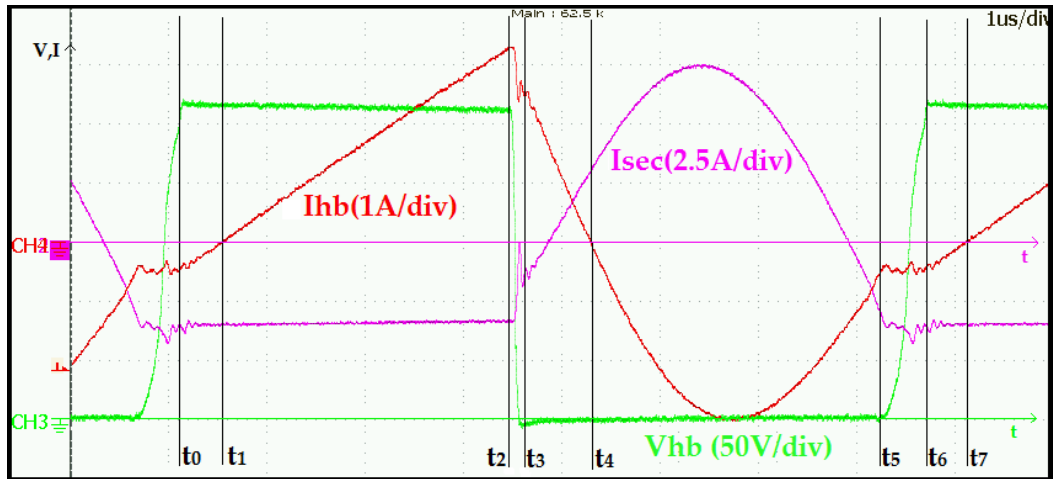
Figure 3. Resonant asymmetric flyback converter waveforms, I hb : tank current, V hb : half bridge middle point voltage, I sec : secondary transformer current.